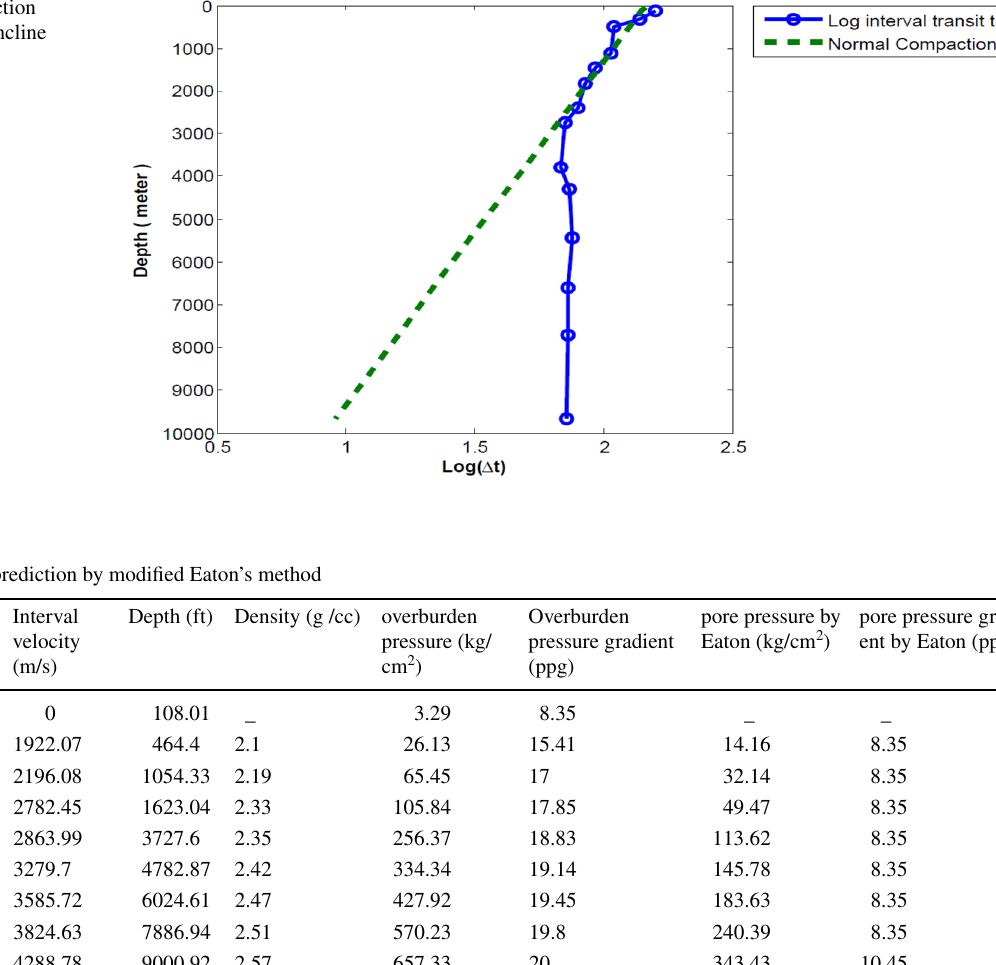
Fig. 16 Normal compaction trend line for CDP 4 syncline